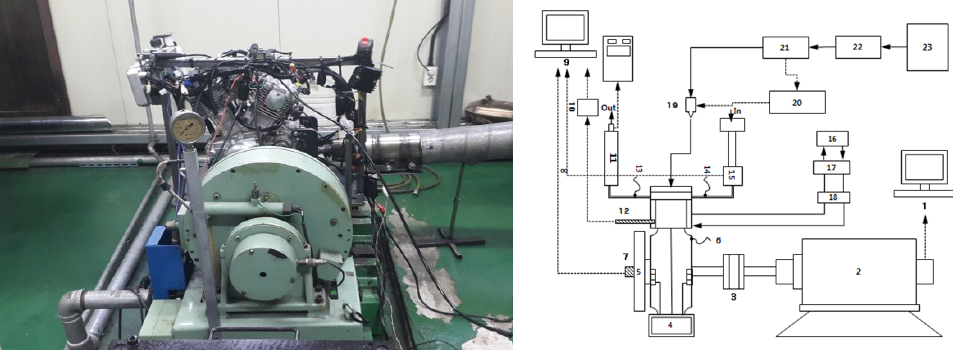
Figure 1. Experimental system setup: 1—dynamometer controller; 2—AVL dynamometer (AVL AG150, 150 kW); 3—coupling; 4—engine (V-twin engine); 5—fly wheel; 6—oil thermocouple; 7—encoder (E40S8-1800-3-T-24); 8—output signal; 9—Horiba combustion analyzer (MEXA-7100DEGR); 10—amplifier; 11—exhaust plenum; 12—pressure transducer; 13—exhaust thermocouple (L36C-18-8G1); 14—intake thermocouple; 15—throttle (89452-22090); 16—oil; 17—pump; 18—filter; 19—injector (16450-C12-235); 20—injector controller; 21—fuel pump; 22—flow meter; 23—fuel tank.